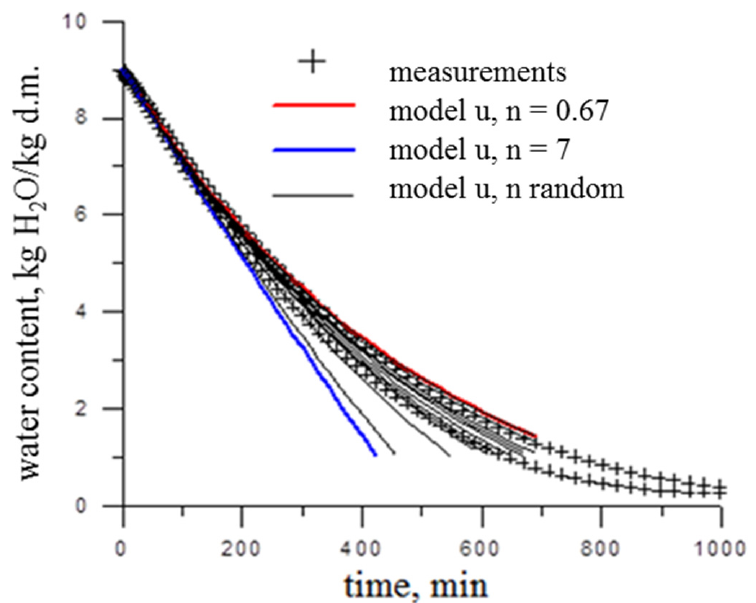
Figure 8. The graphs of models for moisture content changes with random coefficient for leek slices 12 mm thick, during drying at temperature 60 °C.